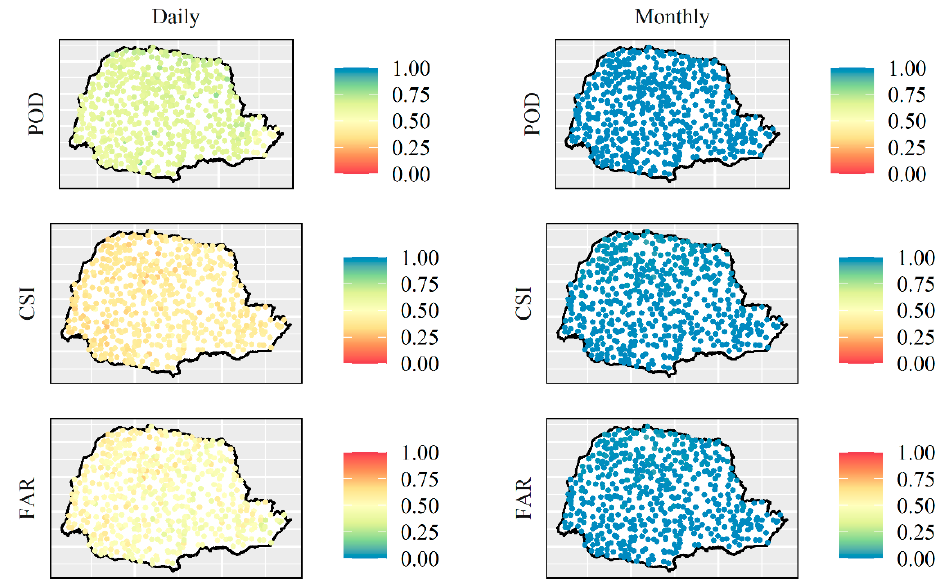
Figure 9. Spatial distribution of the qualitative metrics of IMERG performance on a daily and monthly scale.